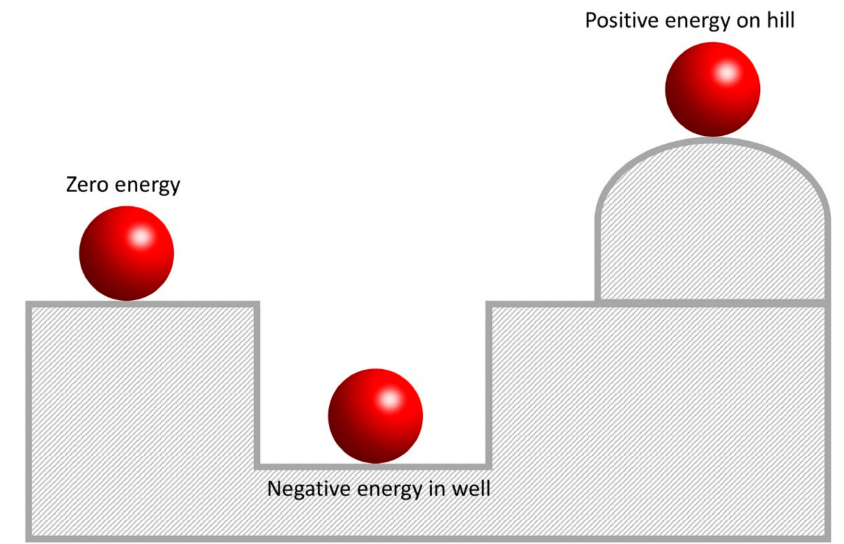
Figure 7. A diagram showing the negative, positive, and zero